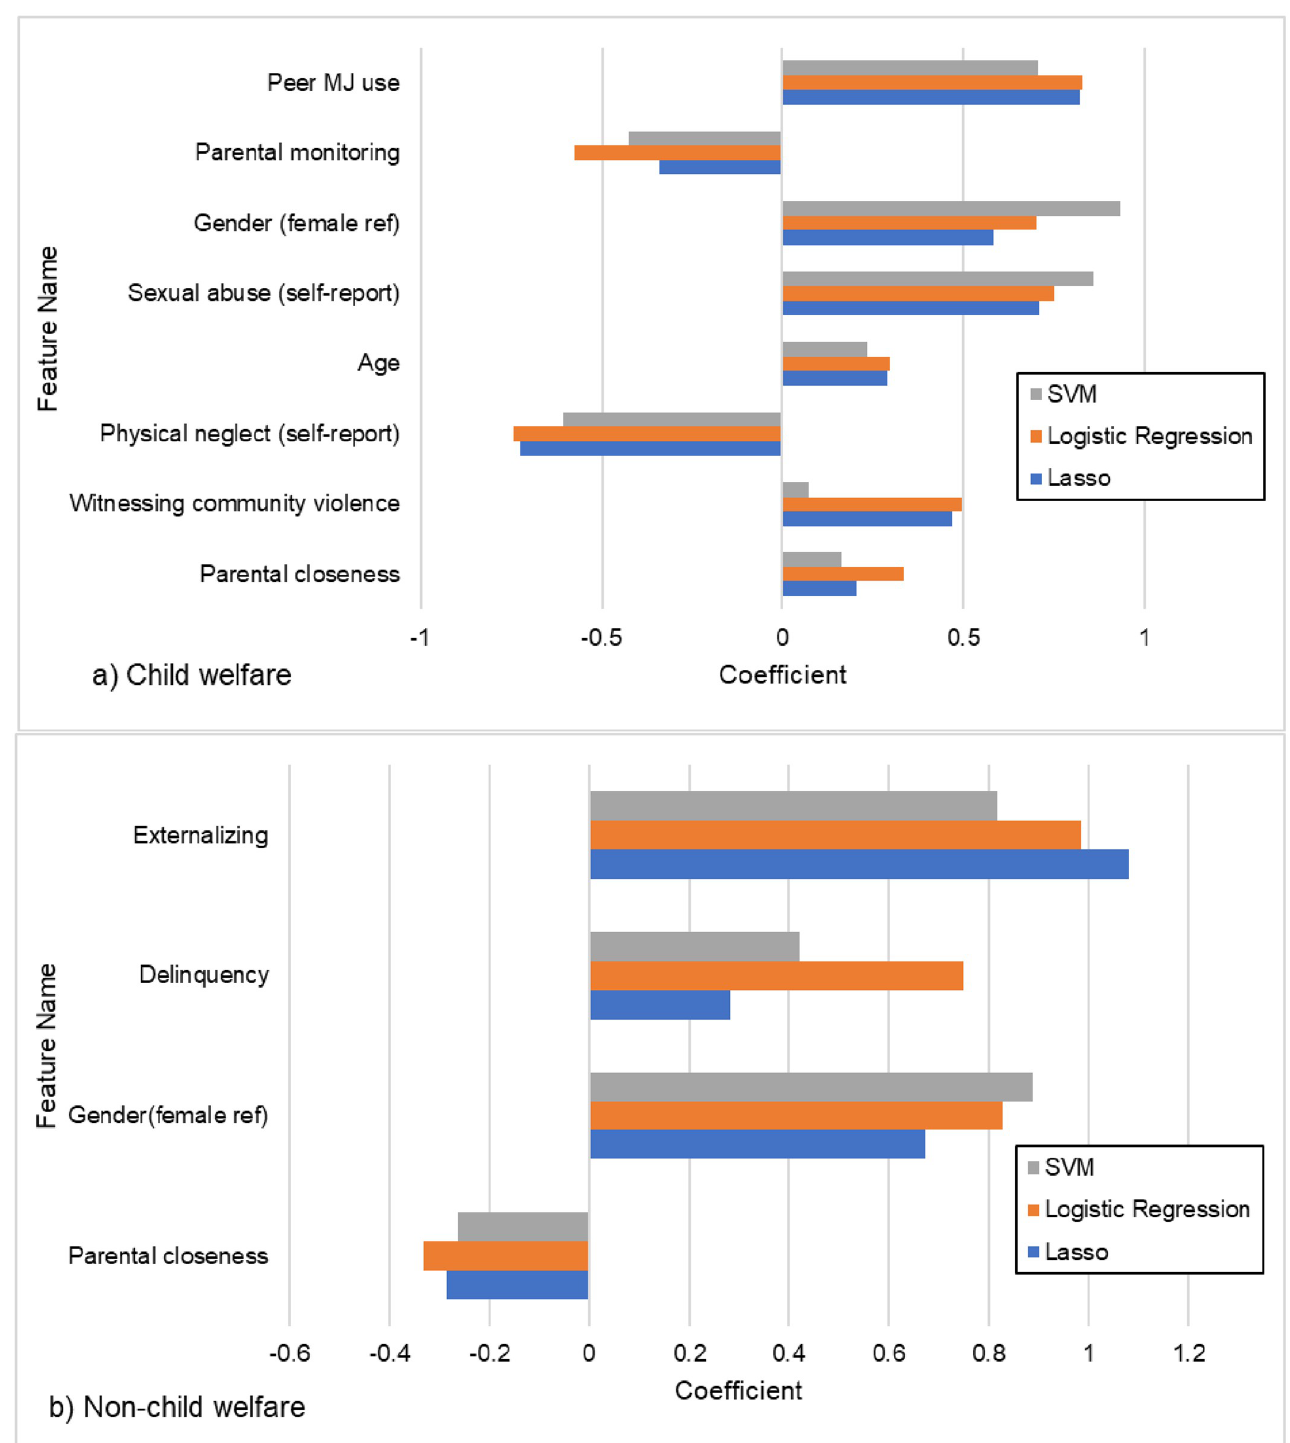
Fig 2. Plot of individual predictors selected by model ranked by coefficient for a) Child Welfare and b) non-Child Welfare groups.